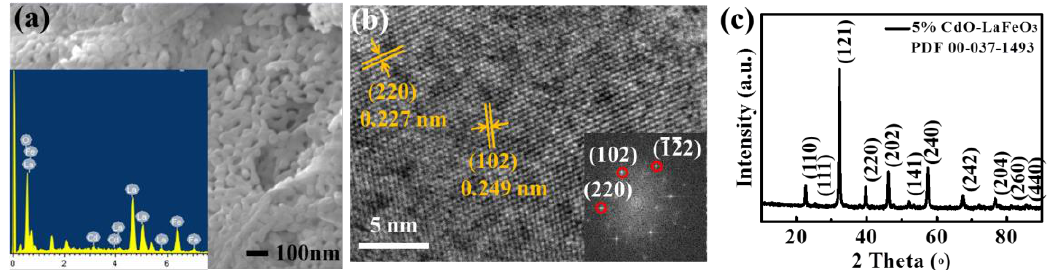
Figure 5. Characterizations of CdO-activated p-type LaFeO 3 : ( a ) SEM image and EDS spectrum (inset); ( b ) HRTEM and FFT (inset) and ( c ) XRD pattern.